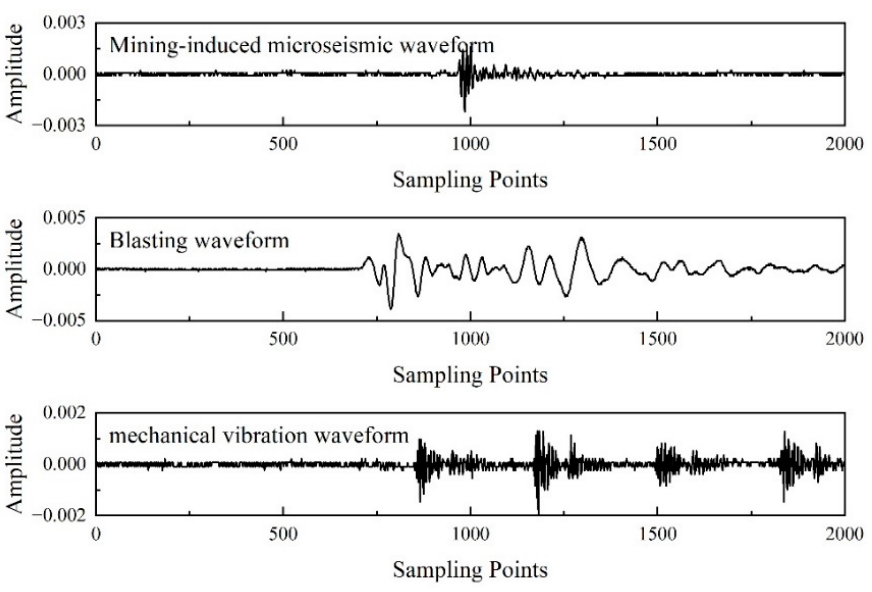
Figure 1. A mining-induced microseismic monitoring system was installed to monitor the safety of goaves in the Huangtupo Copper and Zinc Mine.